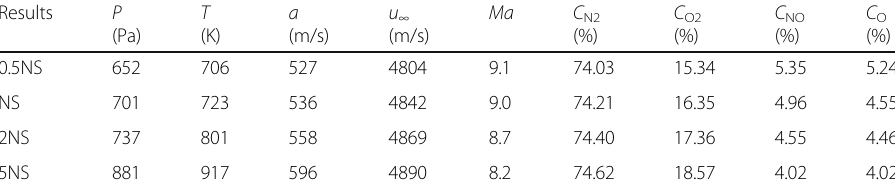
Table 7 Comparison of flow parameters in the centerline at nozzle outlet in the HEG